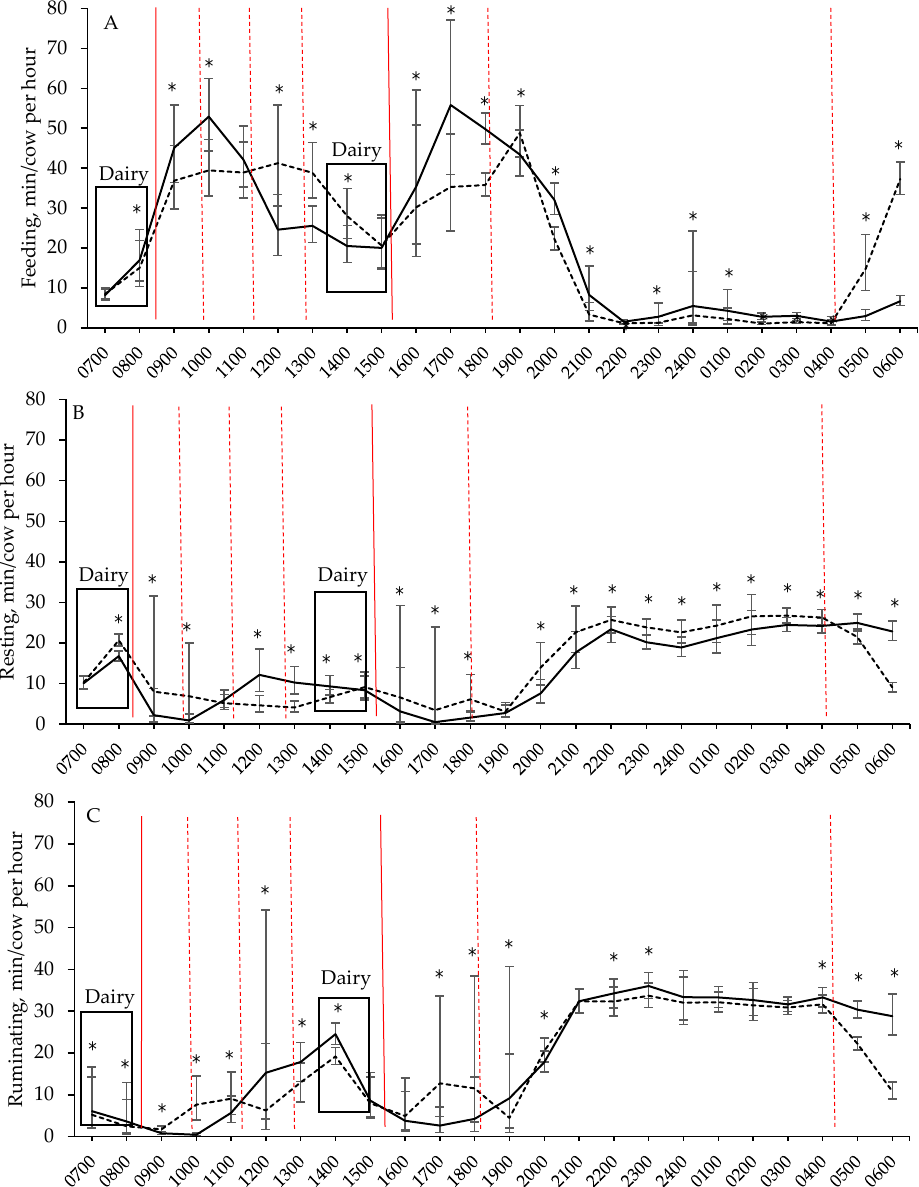
Figure 2. The effects of providing cows their daily pasture allocation over 2 feeds per day (solid line) or 7 feeds per day (dotted line) on time ( y -axis) spent ( A ) feeding, ( B ) resting, and ( C ) ruminating, over 24 h per day ( x -axis). The approximate times that all cows gained access to fresh pasture are indicated by a solid red reference line, while the approximate times that feeds were provided only to cows fed 7 times per day are indicated by a dotted red reference line. Least square means ± 95% confidence interval, calculated using linear mixed models, are presented. Significant differences between treatments are indicated by * ( p < 0.05).